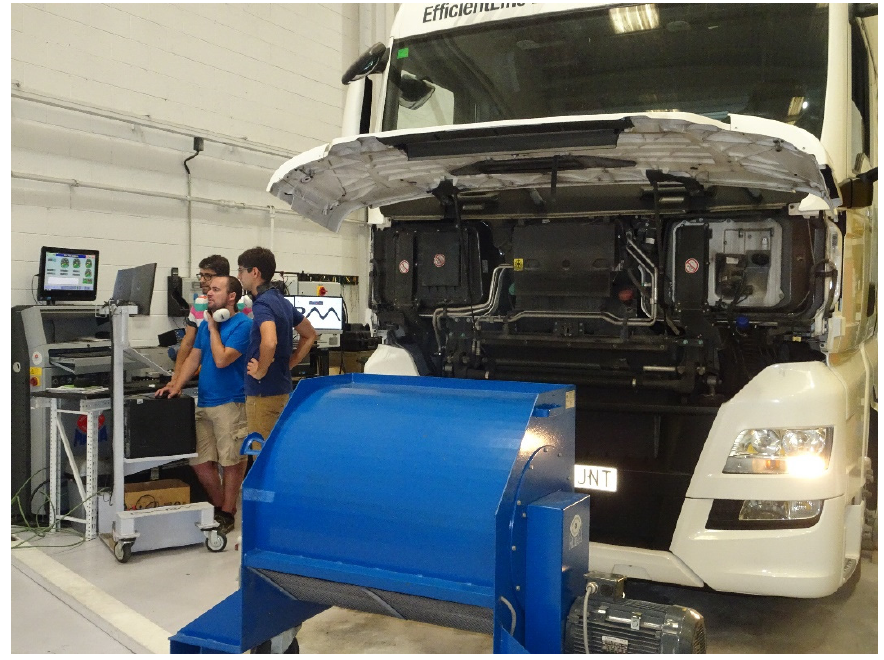
Figure 4. Vehicle being tested on the rolling bench.